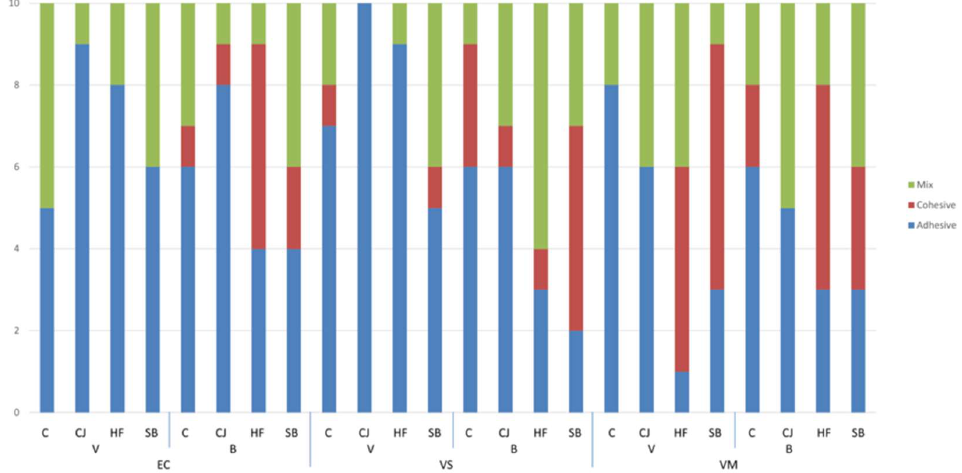
Figure 3. Fracture types of groups. VM, feldspathic; EC, lithium disilicate; VS, zirconia-reinforced lithium silicate; C, control group; CJ, silica-coated group; HF, hydrofluoric acid etching group; SB, sandblasted group; V, Variolink; B, BisCem.